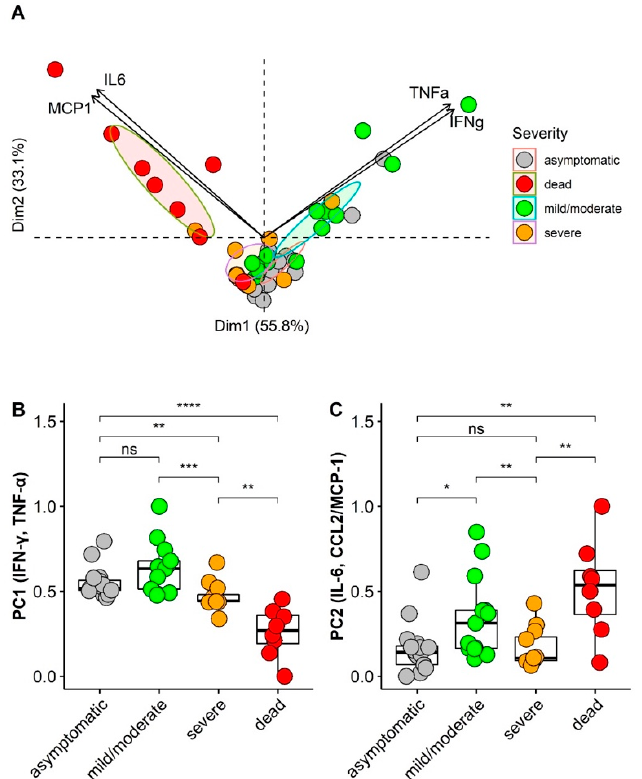
Figure 4. Cytokines/Chemokines profiles in SARS-CoV-2 infected patients. ( A ) PCA biplot shows the two principal components that represent a cumulative percentage of variance of 88.9%, PC1 (55.8%) and PC2 (33.1%). Individual scores for each PC are represented as colored points that are grouped according to severity (ellipses represent 95% confidence interval for each group). Loadings of variables are represented as arrows; the length of each arrow represents the contribution of each variable on each principal component; ( B ) Comparison of individual scores for PC1 (IFN- γ and TNF- α ); ( C ) Comparison of individual scores for PC2 (IL-6 and CCL2/MCP-1); * p < 0.05; ** p < 0.01; *** p < 0.001; **** p < 0.0001.